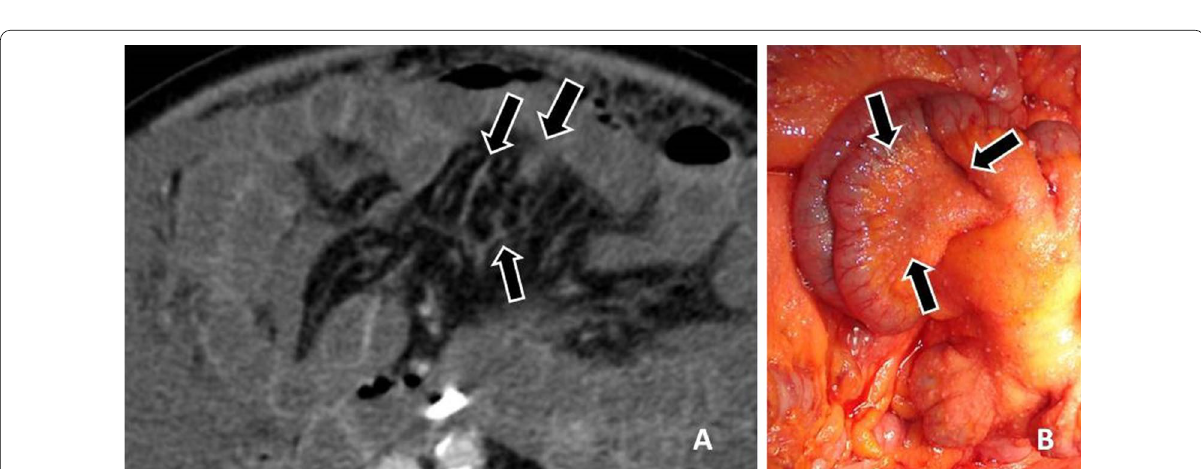
Fig. 12 a Small nodules on the surface of a mesenteric fold (arrow). The omentum presents extensive infiltration (asterisks). b Findings at surgery verifying the presence of tiny implants (arrow) and the omental infiltration